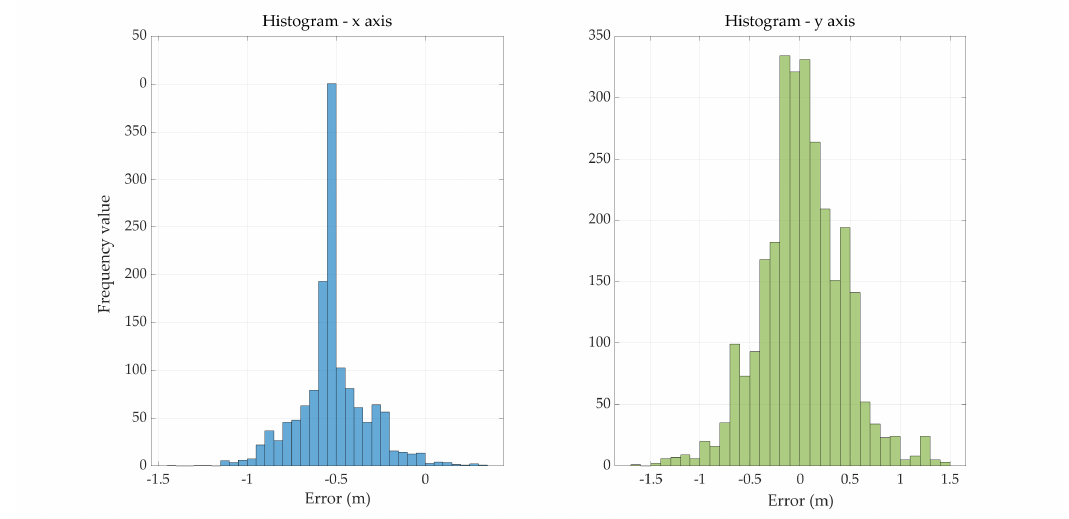
Figure 13. Histogram of the path tracking